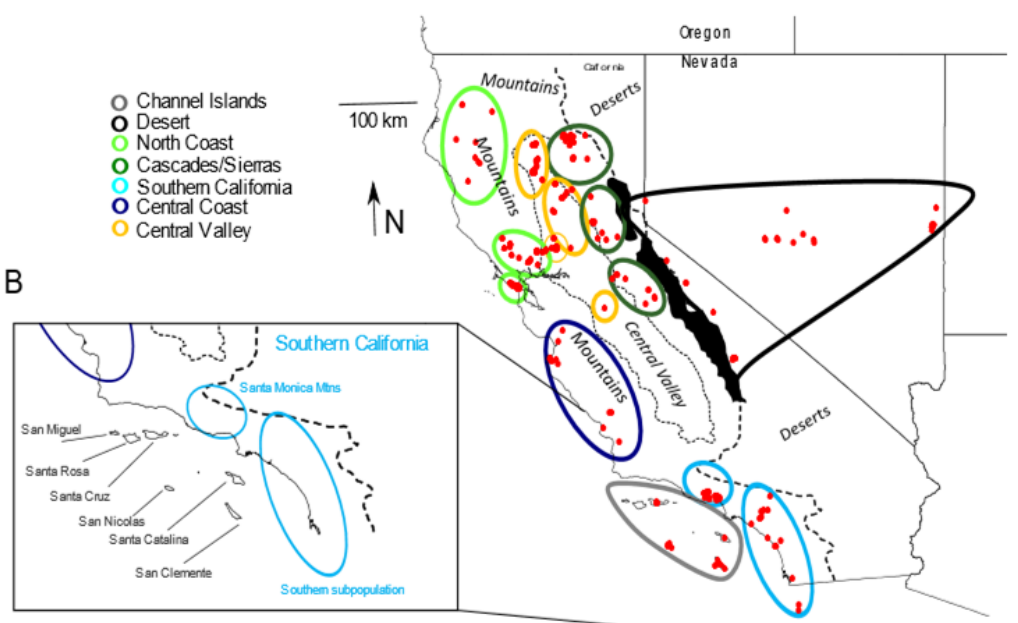
Figure 1. ( A ). Map of 382 western gray fox ( Urocyon cinereoargenteus ) and island fox ( U. littoralis ) samples (red dots) with sampling sites defined by ellipses. Colors of ellipses indicate the broader regional samples used in population tree and genetic diversity statistics. Island fox samples are shown on the four sampled Channel Islands. Black-filled polygons indicate previously glaciated portions of the Sierra Nevada Range. Not shown are a single sample from Yakima County, Washington (Desert sample) and samples from the eastern gray fox in Georgia. ( B ). Inset: names of the six fox-inhabited Channel Islands and two subpopulations of mainland Southern California: the Santa Monica Mountains (including Simi Hills) and the southern